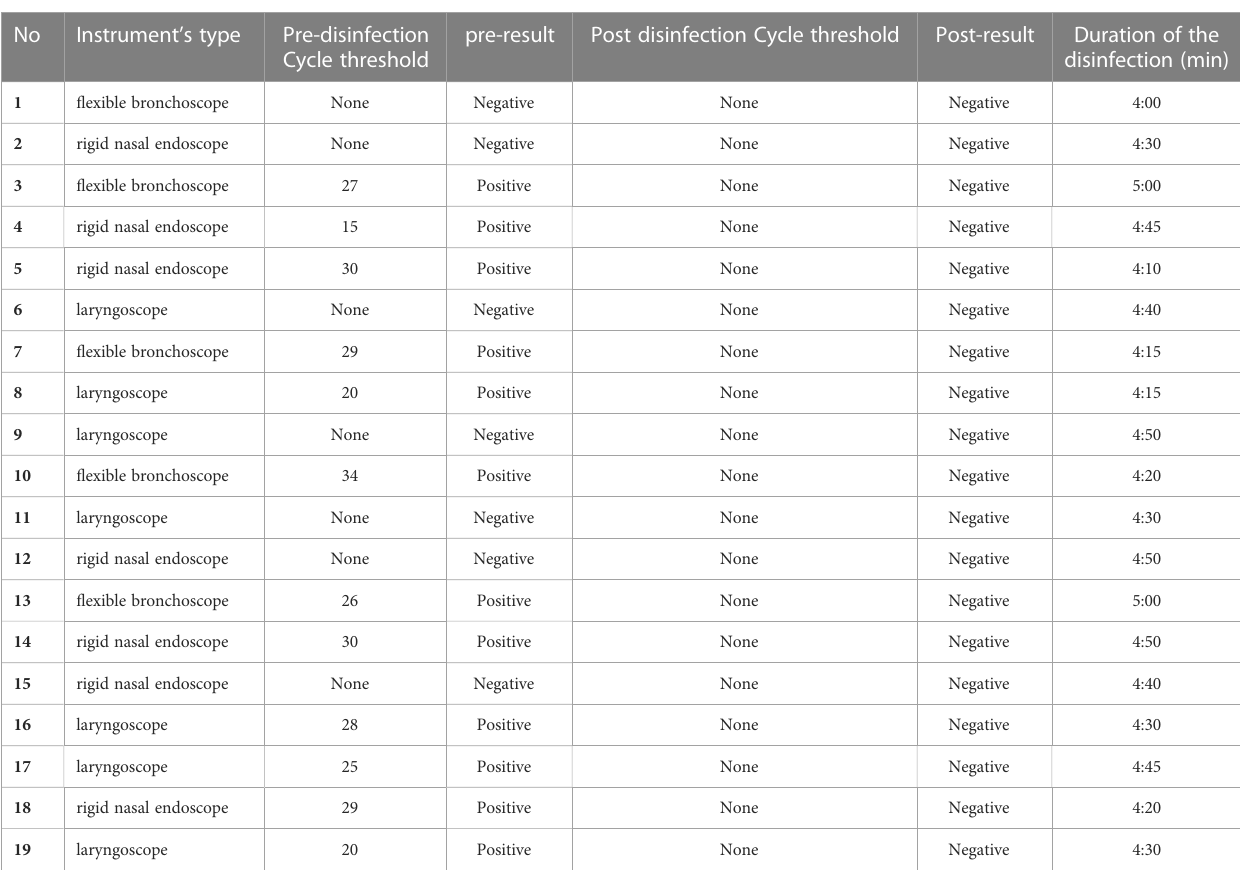
TABLE 1 Swab results of each airway